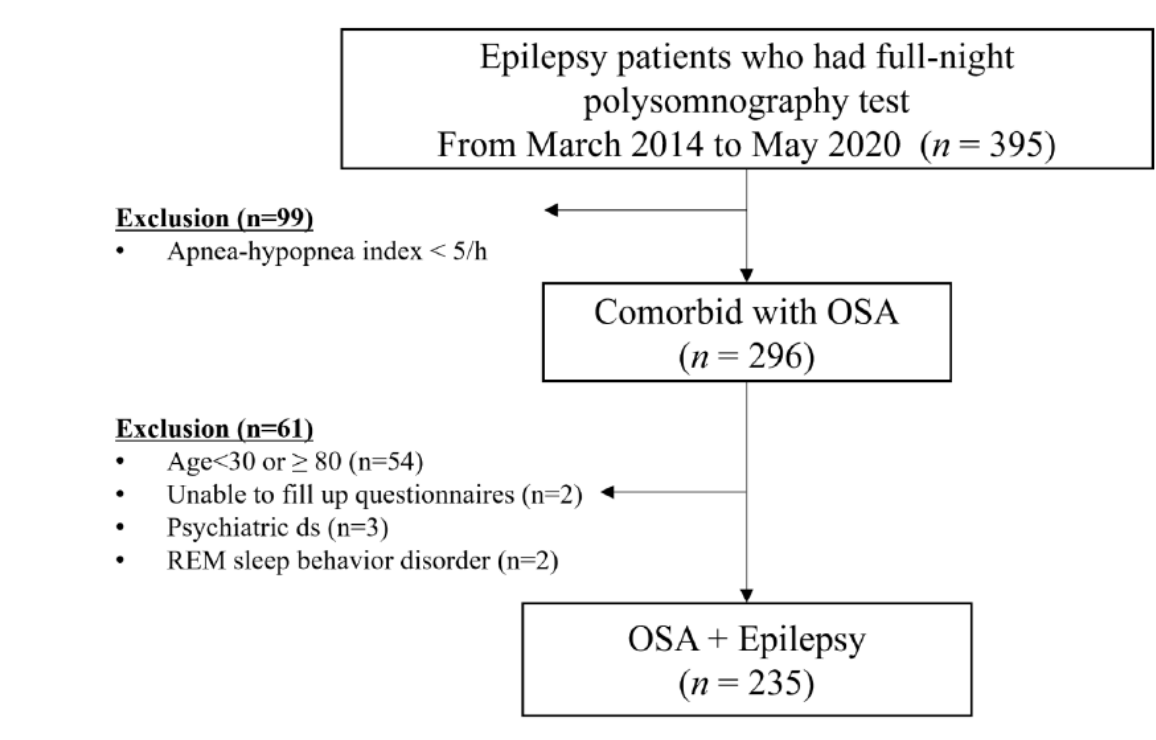
Figure 1. Enrollment log.